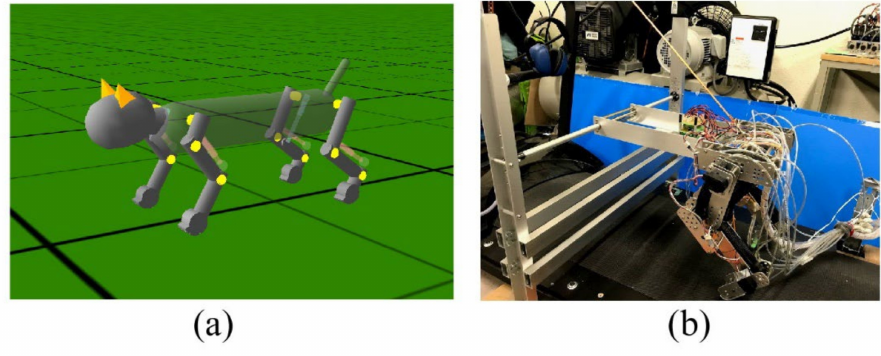
Figure 1. Our previous studies. ( a ) A simulated quadruped model achieving uneven terrain walking; ( b ) a hind leg robot stepping on a speed variable